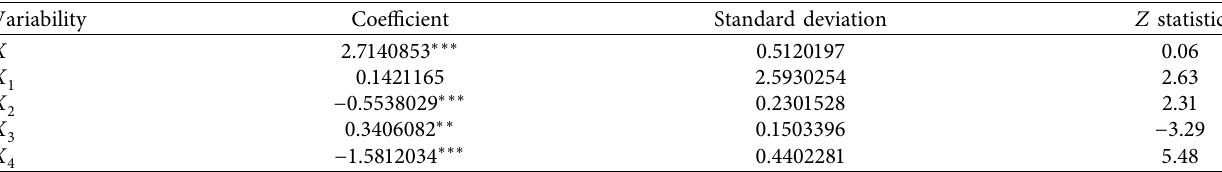
Table 6: Parameter estimation results of impact factors of energy and the economy on the environment.